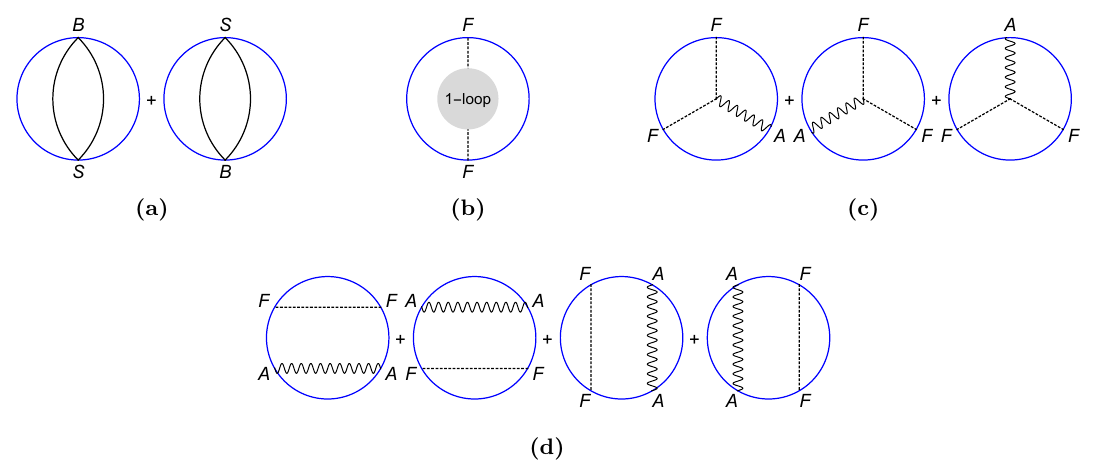
Figure 5. One-loop Feynman diagram for h Tr P (e (cid:0) i H d(cid:28)L bos ( (cid:28) ) W 2 ) i f . F indicates the fermionic quantities de(cid:12)ned in (2.31).